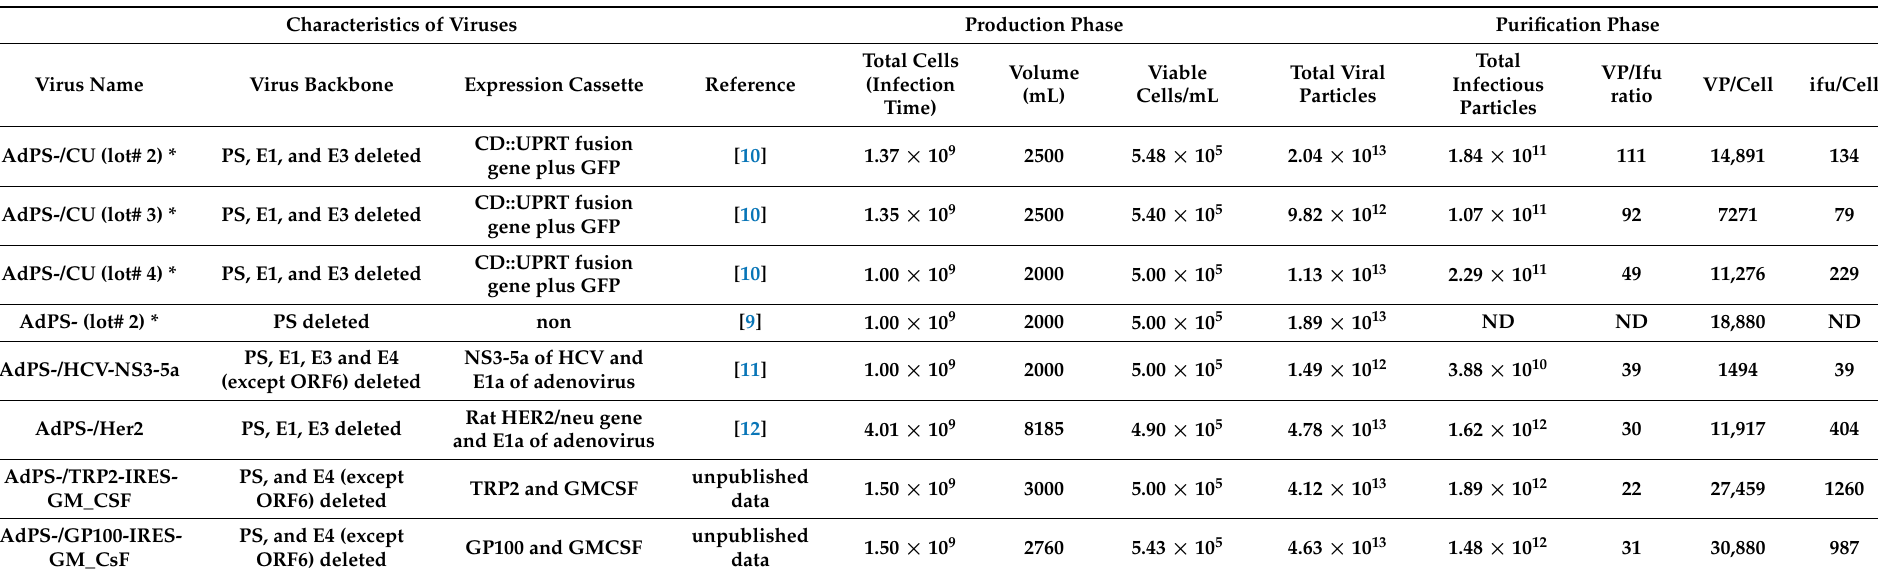
Table 2. Production and purification scale-up of SC-AdVs. Overall, 8 lots of SC-AdVs were produced in the SF-BMAdR- λ R-GyrB-PS-174-12A cell line. The viruses were purified and the infectious particles were quantified after